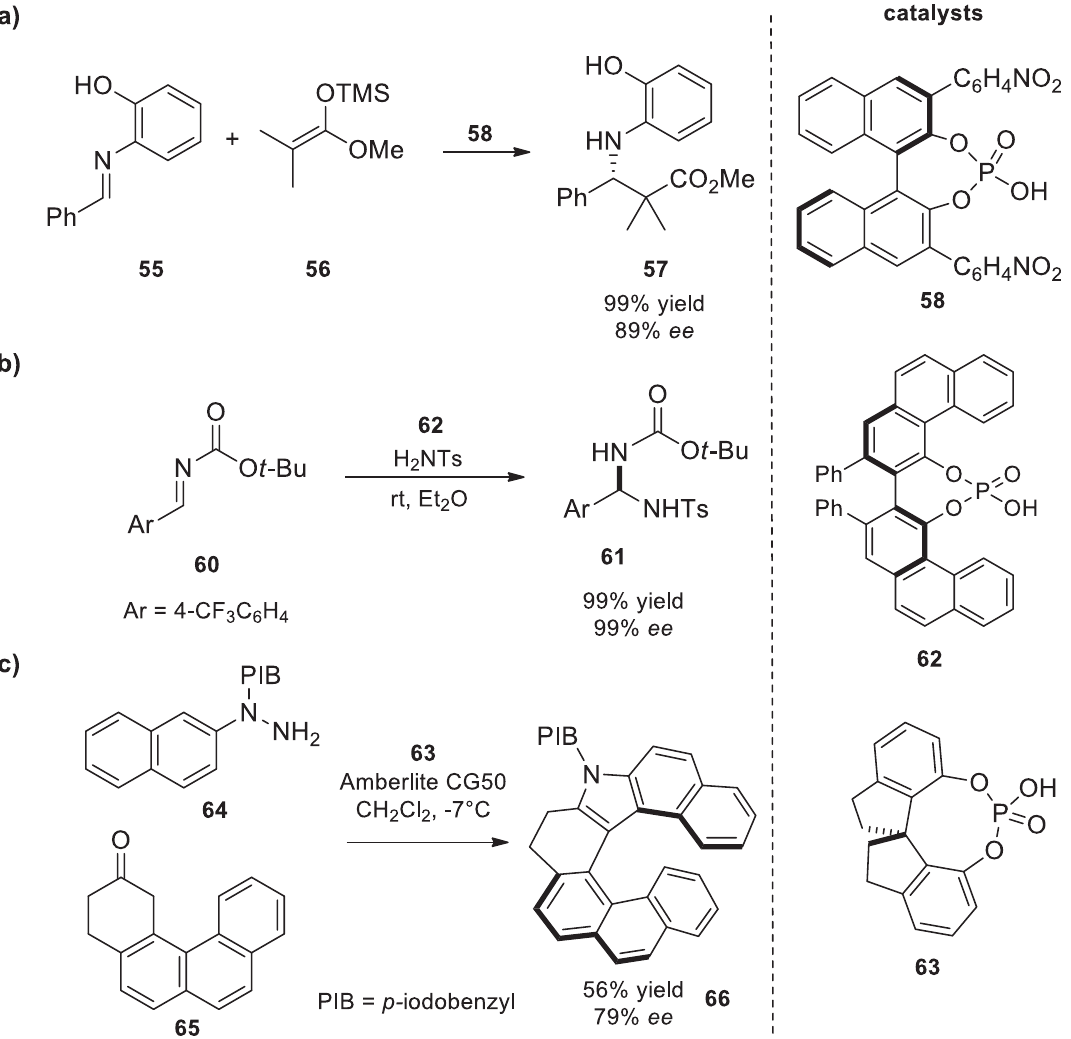
Figure 16 . (a) Enantioselective Mannich-type reaction, from Ref. [71]; (b) BA catalysed imine amidation, from Ref. [80]; (c) Fischer indo- lisation, from Ref.